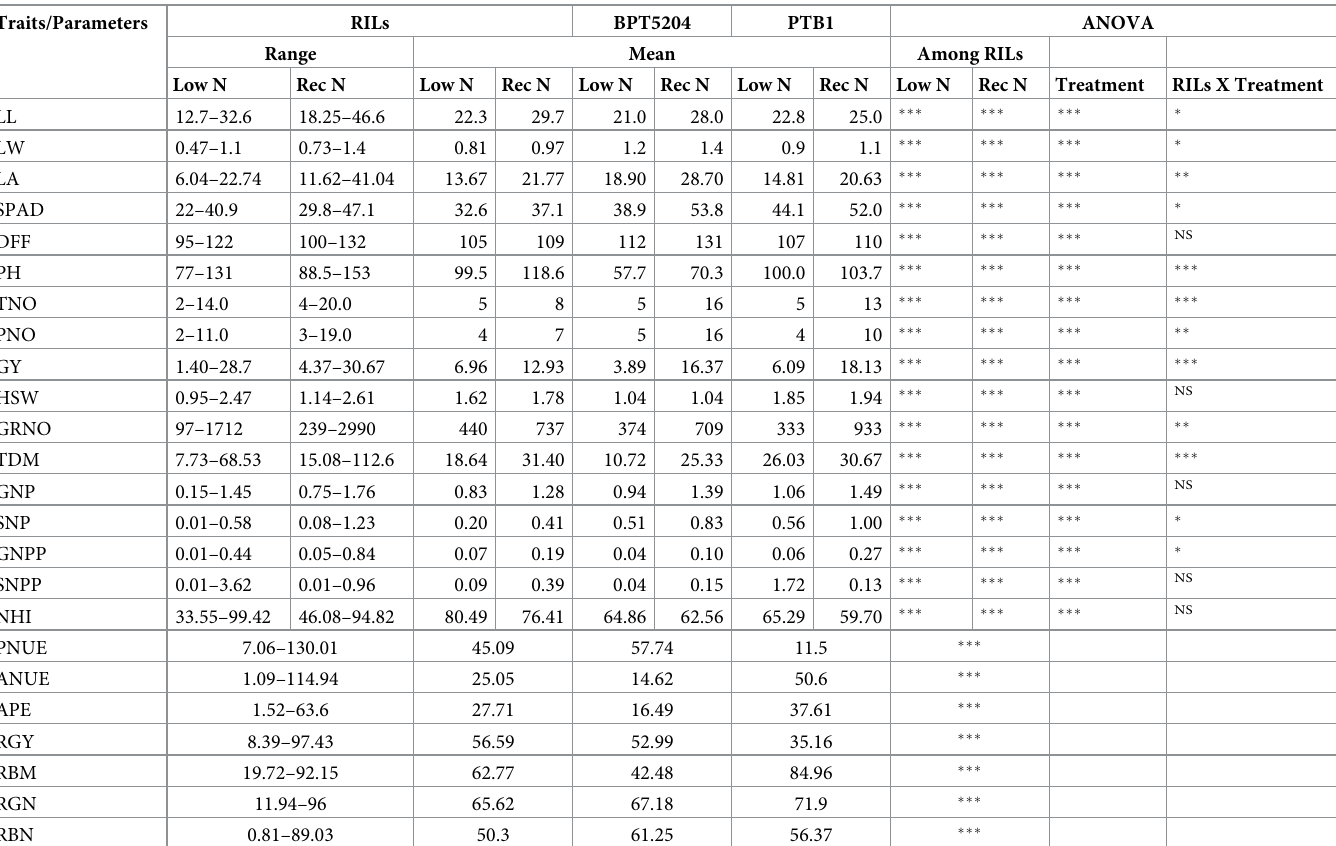
Table 1. ANOVA for leaf, agro-morphological, yield and yield related traits and N content and N use efficiency indices of parents and RILs in wet season.